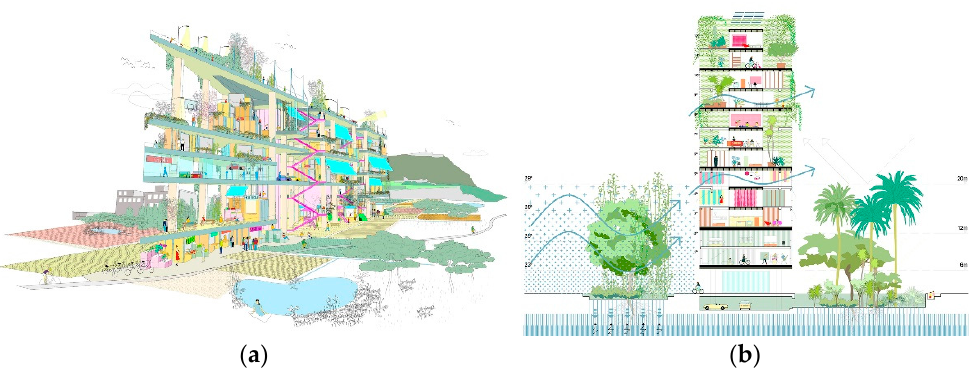
Figure 3. European-Spain 13 proposal: In Movement , Barcelona ( a ) and Green Block collective housing project in Málaga, Spain ( b ). Drawings: Langarita Navarro Arquitectos.